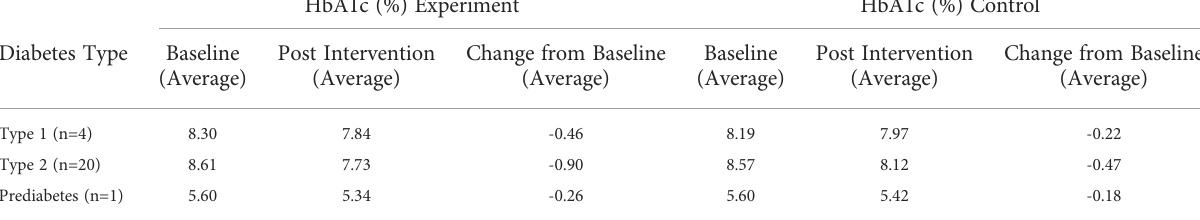
TABLE 5 Trial results according to HbA1c (%) values pooled by mean average for T1DM, T2DM and